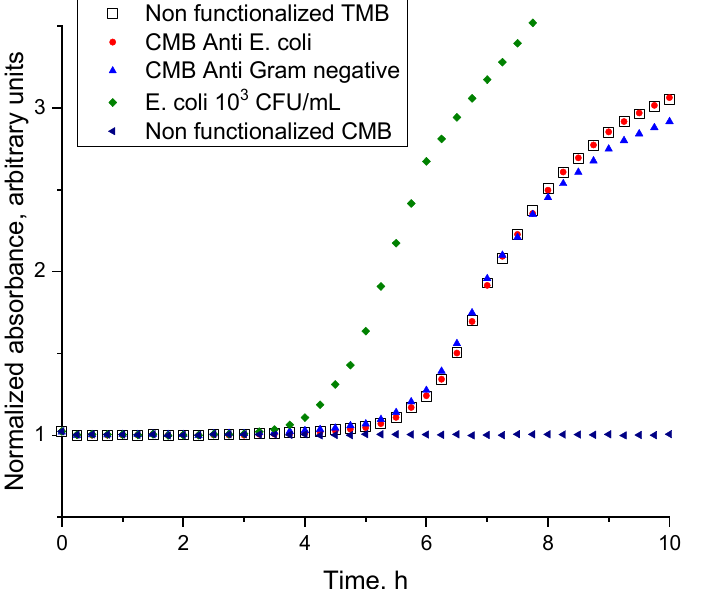
Figure 5. Growth curves of magnetically tagged E. coli upon capture from 10 3 CFU/mL cell suspen- sions using CMB functionalized with Anti E. coli (red dots), Anti gram-negative antibodies (blue triangles), non-functionalized TMB (empty squares), and non-functionalized CMBs (arrow heads) compared with the growth curves of the untagged 10 3 E. coli (green diamonds) cell suspension. Nevertheless, the growth of the cells captured by MB (Figure 5) shows that the bac- teria are maintaining their viability after the capture and can be further analyzed and characterized by complementary methods. The MBs were also tested for nonspecific adsorption, and the signal (Figure 5) showed the absence of bacterial growth for E. coli upon capture from 10 3 CFU/mL cell suspensions using non-functionalized CMBs, which is indicative of a very low nonspecific binding as well as a high non-specific binding for TMBs. The growth curve of the mag- netically tagged E. coli upon capture from 10 3 CFU/mL cell suspensions using non-func- tionalized TMBs is similar to that of the magnetically tagged E. coli with CMB, with highly specific functionalization. The high nonspecific binding for tosylated beads (Table 2) is thus also confirmed in absorbance assays (Figure 5). Due to the observed non-specific binding of the MBs, experiments on real samples were conducted using only the carbox- ylated MB, with a mixture of AO staining and a direct, microscopy assay on IMS clusters. 3.4. Microscopy Assay for Urine Samples Performing rapid, cost-, and labor-effective screening of clinical samples is highly desirable since, typically, of the total number of samples analyzed daily, more than half (~60%) are negative. Rapid screening in the urine sample can lead to a faster result, which can lead to a better medical decision for patients. It can also limit the unnecessary urine cultures. While, from the clinical microbiology laboratory perspective, samples are character- ized as negative when less than 10 3 CFU/mL is present and positive for bacterial loads (of a single type of pathogen) above 10 5 CFU/mL, when mixed populations are present at detectable levels, the samples are usually disregarded as non-valid and assumed to be contaminated. The proposed procedure with the acridine orange staining of MB clusters formed in urine samples spotted on a microscope slide and examined under a fluorescent micro- scope yields characteristic images with cluster sizes, morphologies, and structure in a fast classification of bacterial load status.